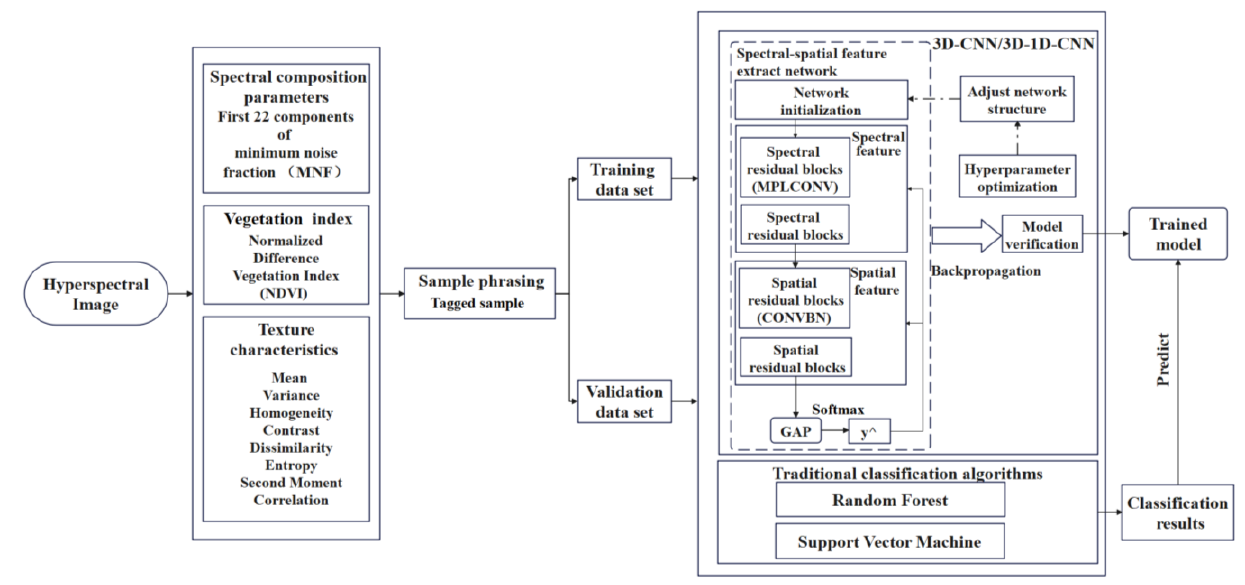
Figure 3. The flowchart of this research.